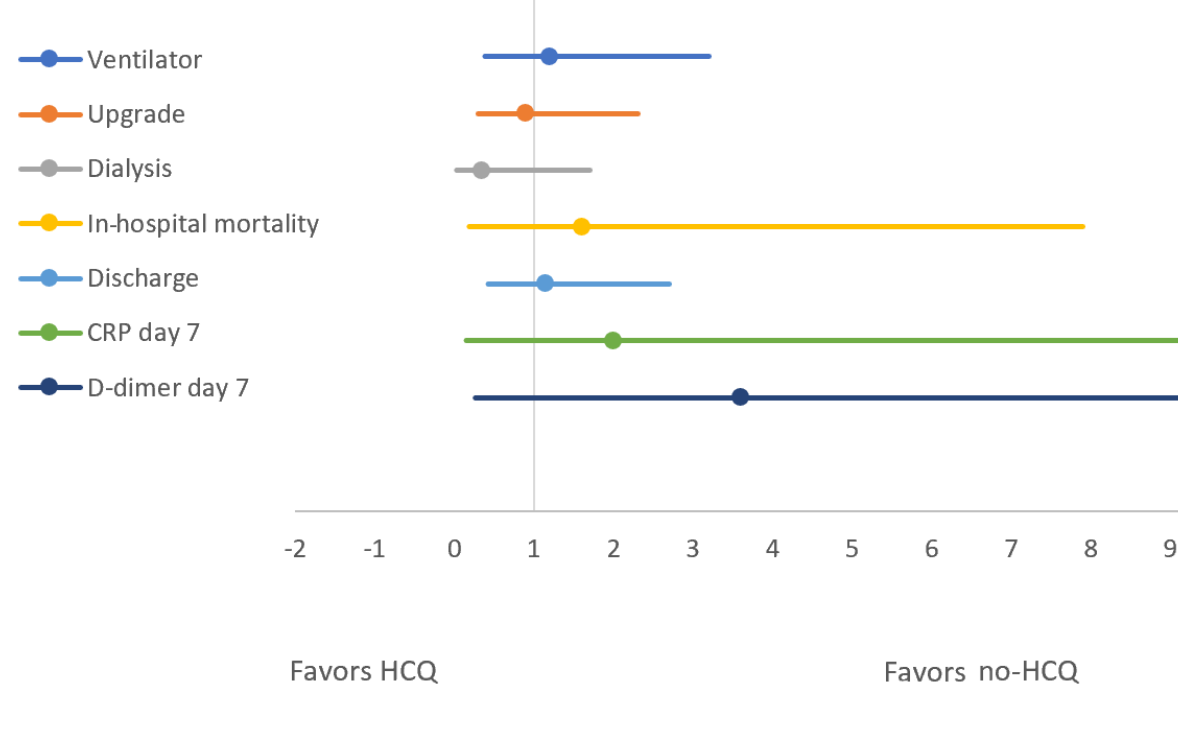
Figure 5. Forest plot comparing the adjusted odds of outcomes between hydroxychloroquine (HCQ) and no-HCQ groups. CRP: C-reactive